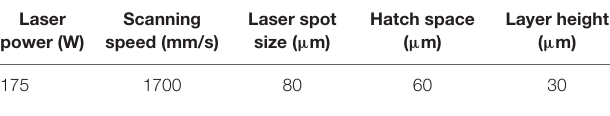
TABLE 1 | LPBF process parameters used for coupon